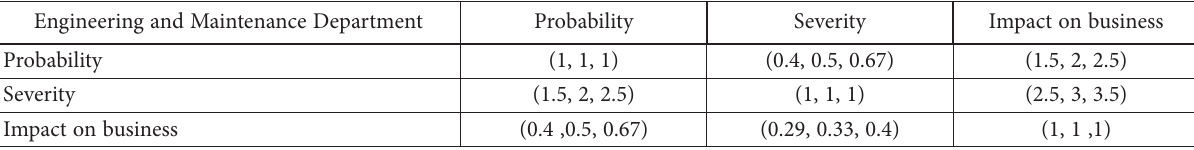
Table 2. Criteria comparison for Engineering and Maintenance Department